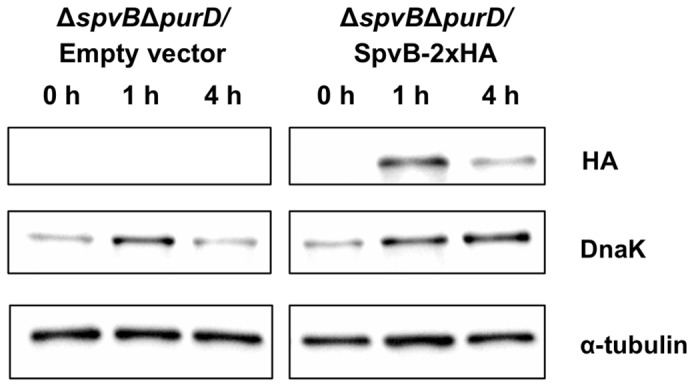
Induced expression of SpvB-HA in tumor cells.HeLa cells were infected with Salmonella MPO325 bearing the empty vector (pMPO52) or the plasmid producing SpvB-2xHA (pMPO1612) and induced by salicylate for indicated times under the conditions that restrict bacterial growth as described previously. Whole cell extracts were subjected to Western blotting to detect HA epitope fused to SpvB (68 kDa). The bacterial chaperone DnaK (70 kDa) was used as a control to confirm the presence of bacteria inside the tumor cell. Equal loading of the samples was confirmed by α-tubulin (60 kDa).